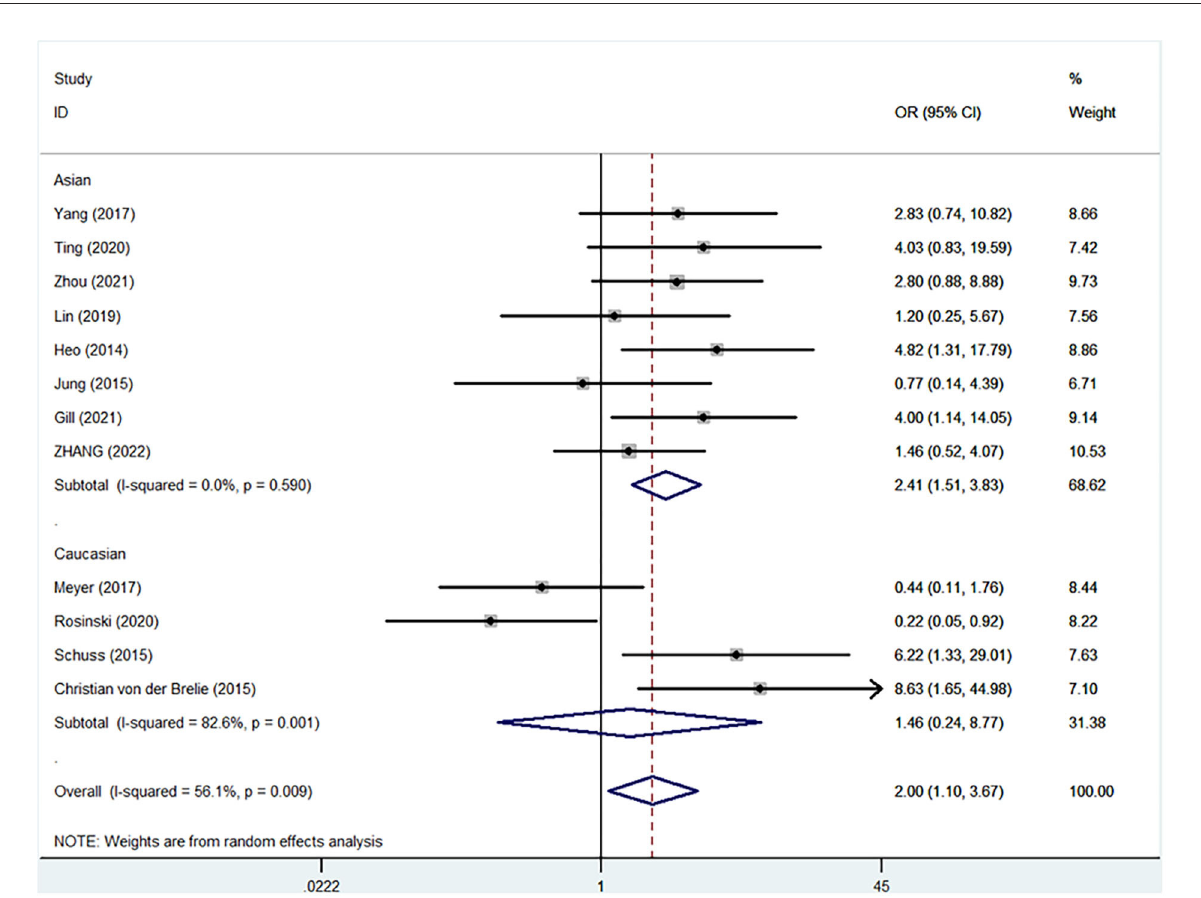
FIGURE2 Comparisons of overall postoperative complications between staged and simultaneous cranioplasty and ventriculoperitoneal shunts. OR, odds ratio; CI, confidence